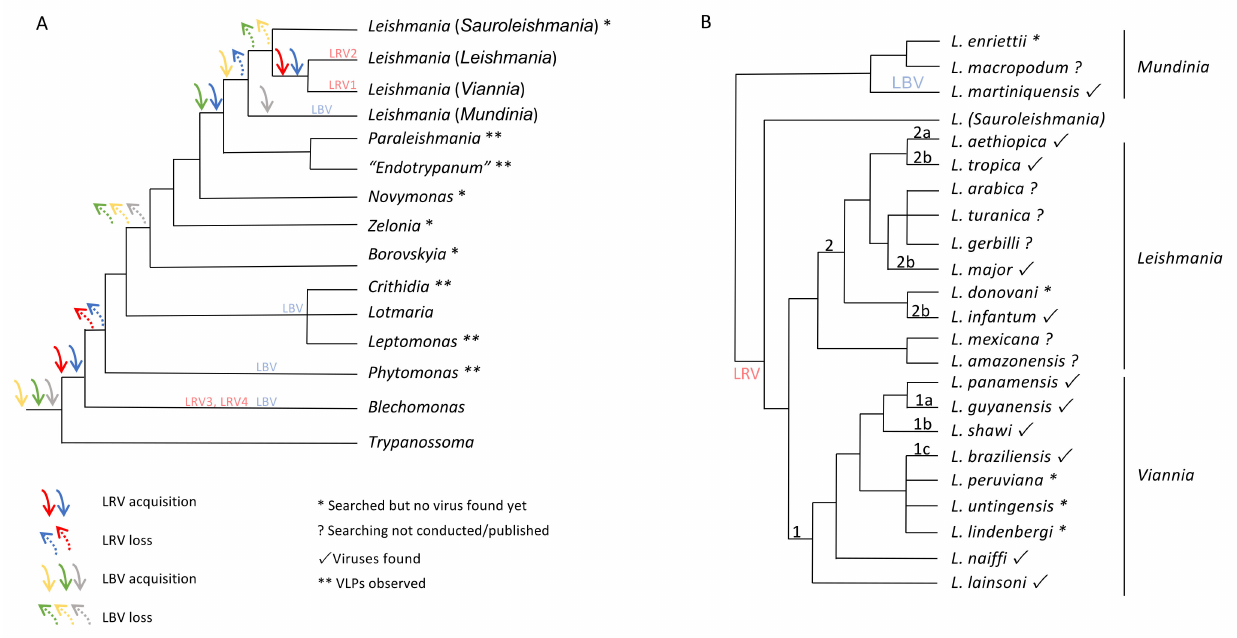
Figure 2. Schematic phylogenetic tree for the family Trypanosomatidae ( A ) and the genus Leishmania ( B ) based on published data [2,3,15] showing possibilities of Leishbunyavirus (LBV) and Leishmania RNA virus (LRV) acquisition by members of the family Trypanosomatidae and LRV dispersion across Leishmania species. Three scenarios are possible for LBV (green, yellow and grey arrows): green—ancient acquisition, with possible loss (dashed green arrow) in the first Leishmaniinae split and new acquisition in the clade containing Leishmania , Paraleishmania , and “ Endotrypanum ”, followed by loss in the split of Leishmania ( Mundinia ) from the other three Leishmania subgenera. This scenario assumes LBV not infecting Novymonas , Zelonia and Borovskyia and virus-like particles (VLPs) found in the clade containing Paraleishmania and “Endotrypanum” as LBV; yellow—the same as green, but with the last acquisition occurring in the split of L . ( Mundinia ) from the other Leishmania subgenera and subsequent loss in members of the other three Leishmania subgenera, assuming VLPs found in the clade Paraleishmania and “Endotrypanum” are not LBV; grey—ancient with possible loss (dashed grey arrow) in the first Leishmaniinae split and new acquisition when L . ( Mundinia ) split from the other Leishmania subgenera. Scenarios expected for LRV: blue—acquisition by a monoxenous trypanosomatid followed by sequential loss when another dixenous clade appears and acquisition in the clade containing Leishmania , Paraleishmania, and “Endotrypanum”, followed by loss when L . ( Mundinia ) split from the other Leishmania subgenera and a new acquisition by clade L . ( Viannia )/ L . ( Leishmania ); this scenario assumes VLPs found in the clade containing Paraleishmania and “Endotrypanum” are LRV and the possibility of LRV infecting all Leishmania subgenera; red—acquisition by a monoxenous trypanosomatid followed by sequential loss when another dixenous clade appears and a new acquisition by clade L . ( Viannia )/ L . ( Leishmania